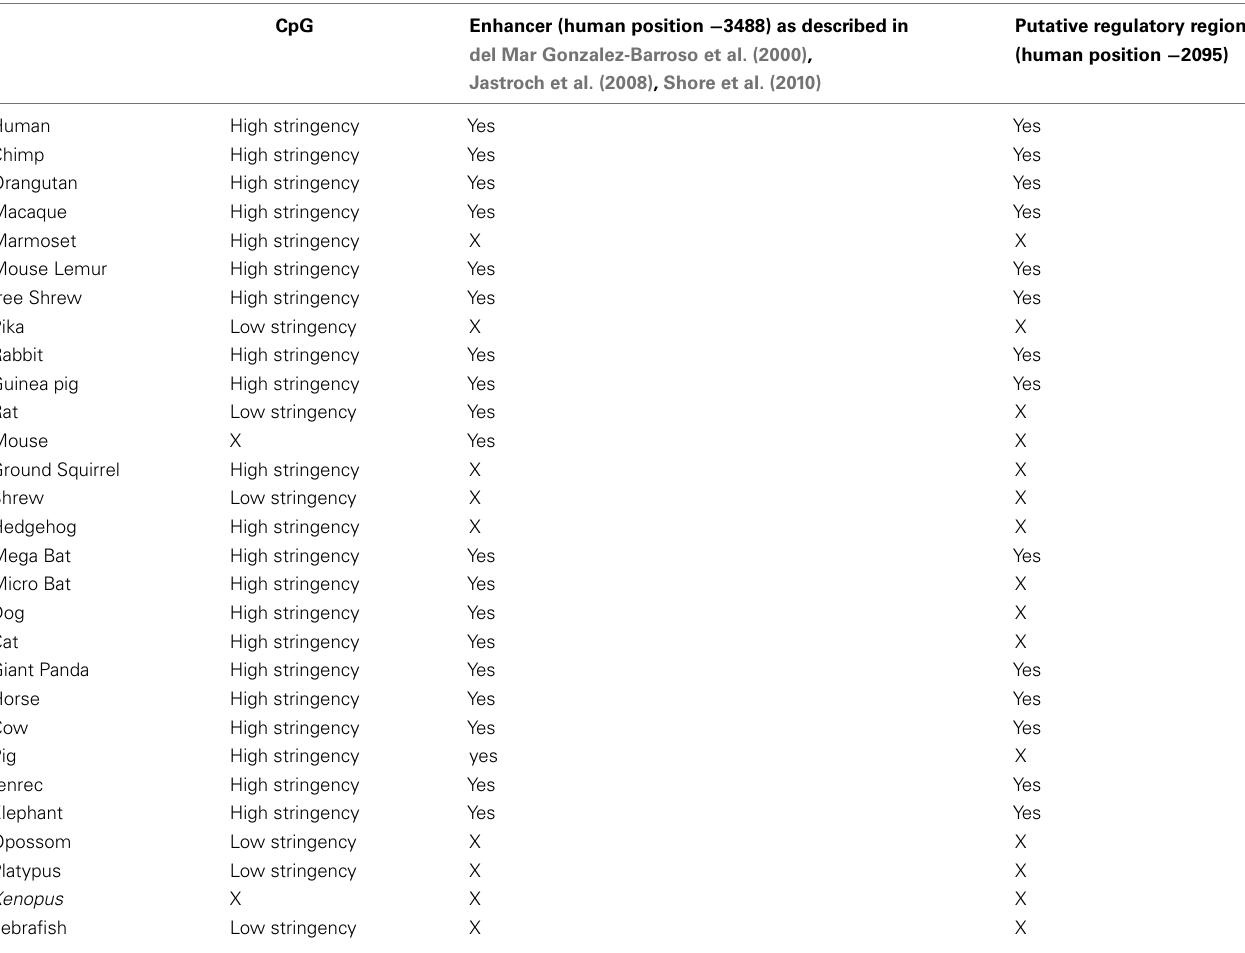
High stringency regions represent CpG islands identified by the CpGLH algorithm with default settings, low stringency regions represent CpG islands identified by the CpGLH algorithm with relaxed settings (see Materials and Methods). Putative Regulatory Region represents a 500bp region conserved in some species containing multiple consensus response